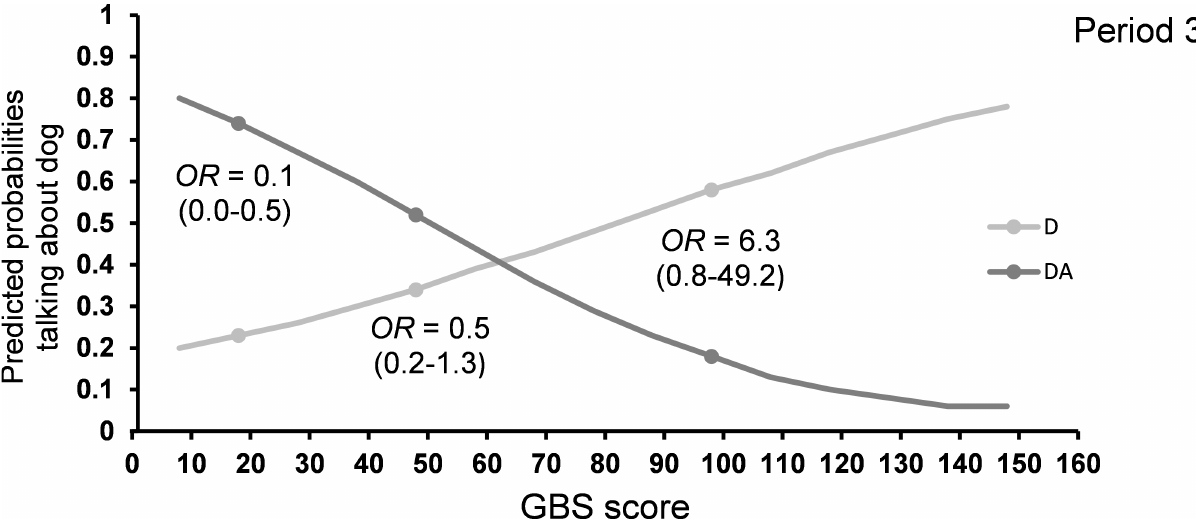
Fig 6. Predicted probability for talking about the dog in period 3 estimated for the range of GBS scores and separately for D and DA visits. D: visits with a dog, no activity, DA: visits with a dog, with activity. GBS scores of 18, 48 and 98 are marked with a dot. The odds ratios (OR) for each of these GBS values are shown. The Gottfries-Br å ne-Steen Scale (GBS). https://doi.org/10.1371/journal.pone.0251571.g006 higher the GBS score, the lower the odds of taking part in the activity (period 1: F